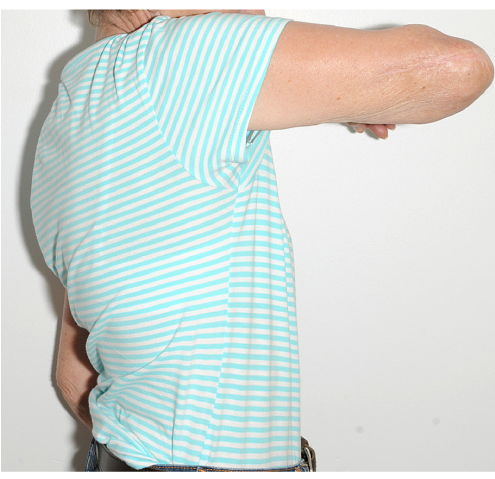
Figure 8. A side view clinical photograph for the third case showing active shoulder forward